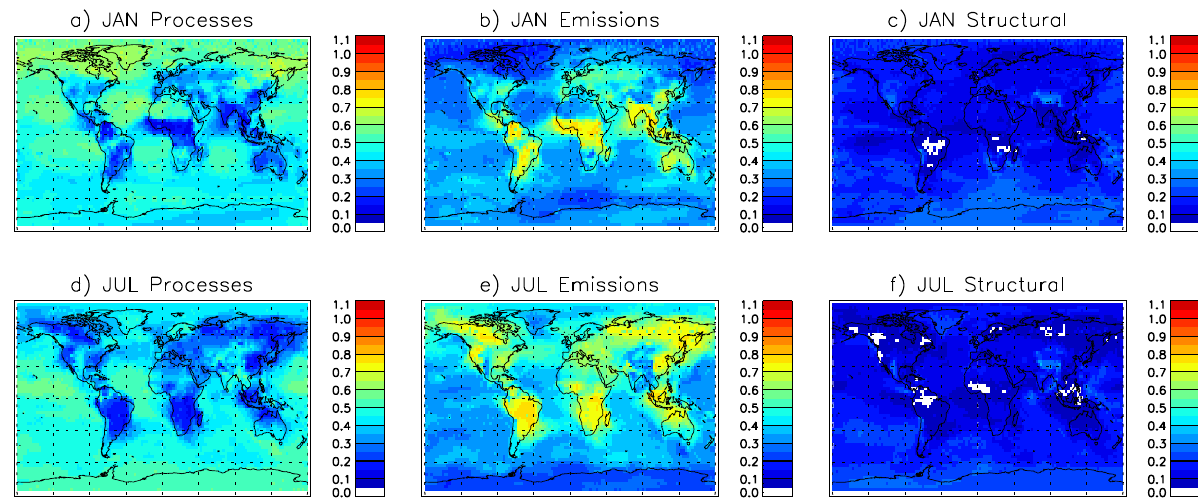
Fig. 10. The contribution to the relative uncertainty according to microphysical processes (left column), emissions (middle column) and model structures (right column) for January (top row) and July (bottom row). The relative uncertainties ( σ CCN ,i /µ CCN ) for each of the 28 parameters i shown in Fig. 7 are summed according to the classification of the parameters shown in Fig. 8. The two SOA-related parameters are included in both the processes and emissions